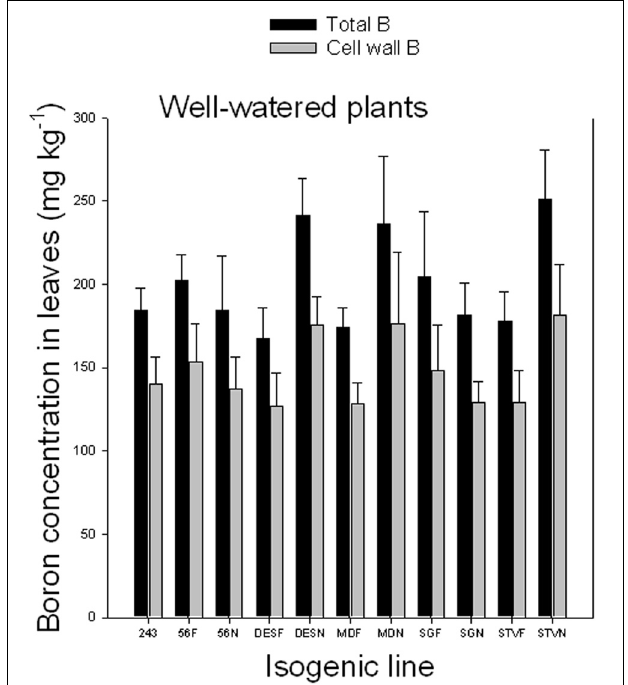
FIGURE 2 | Total and cell wall boron in leaves as affected by near isogenic mutant lines for fuzzless seed trait under well-watered conditions. In each isogenic line, F refers to a fuzzy line and N refers to its equivalent fuzzless line. Since the experiment was repeated twice and the results were pooled and combined, bar values are mean of eight replicates ± SE (standard error of the